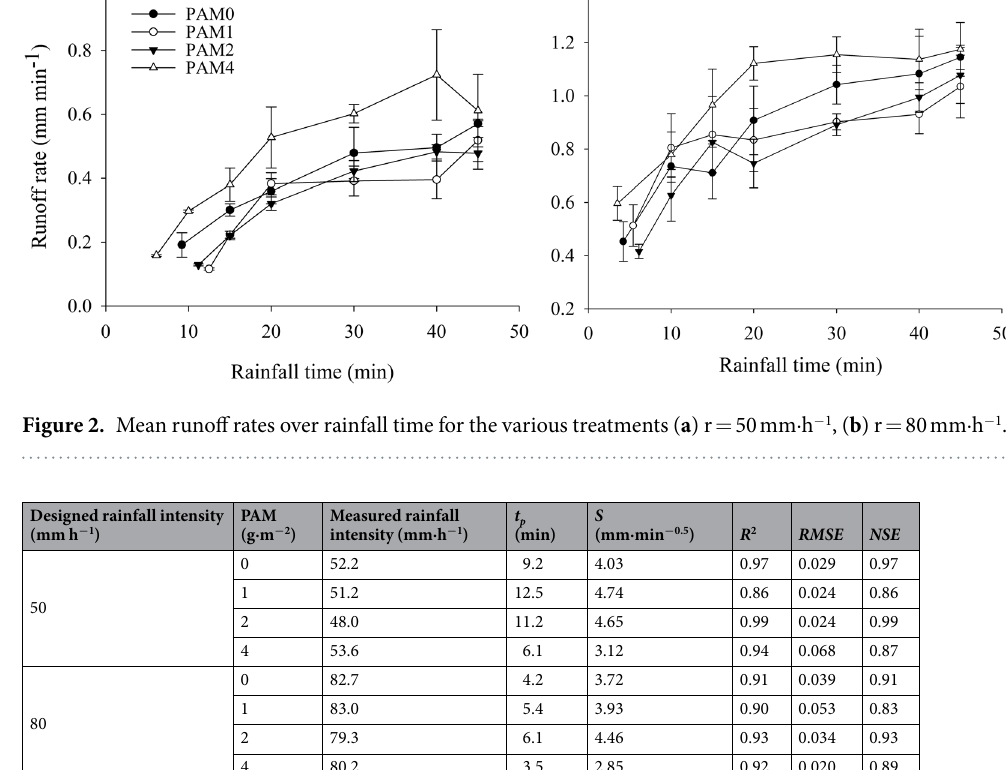
Table 1. Values of measured rainfall intensity, initial runoff time ( t p ), S , R 2 , RMSE and NSE for all treatments after fitting the experimental